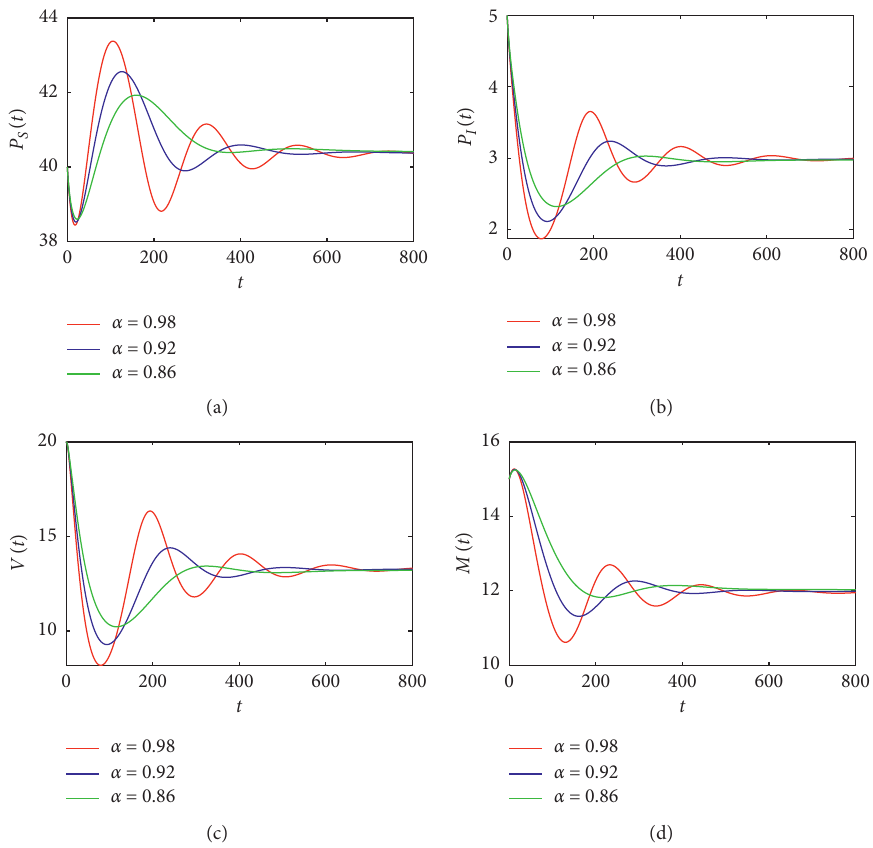
Figure 4: The time series of system (3) when α � 0.98, α � 0.92, α � 0.86, and τ �